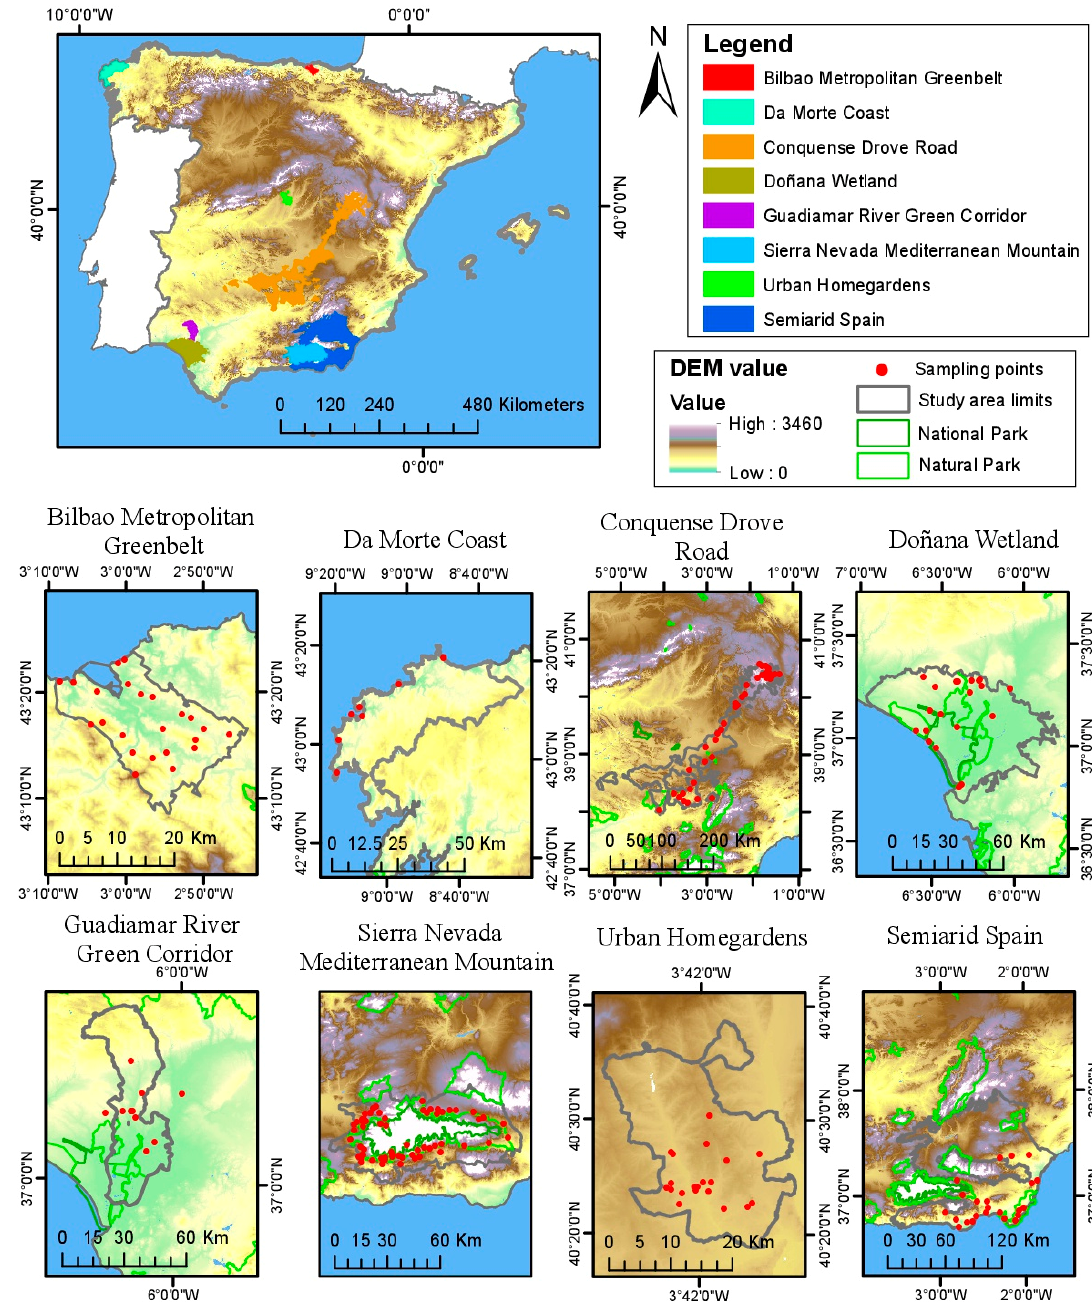
Figure 1. Location of the eight study sites across ecosystem types in Spain.